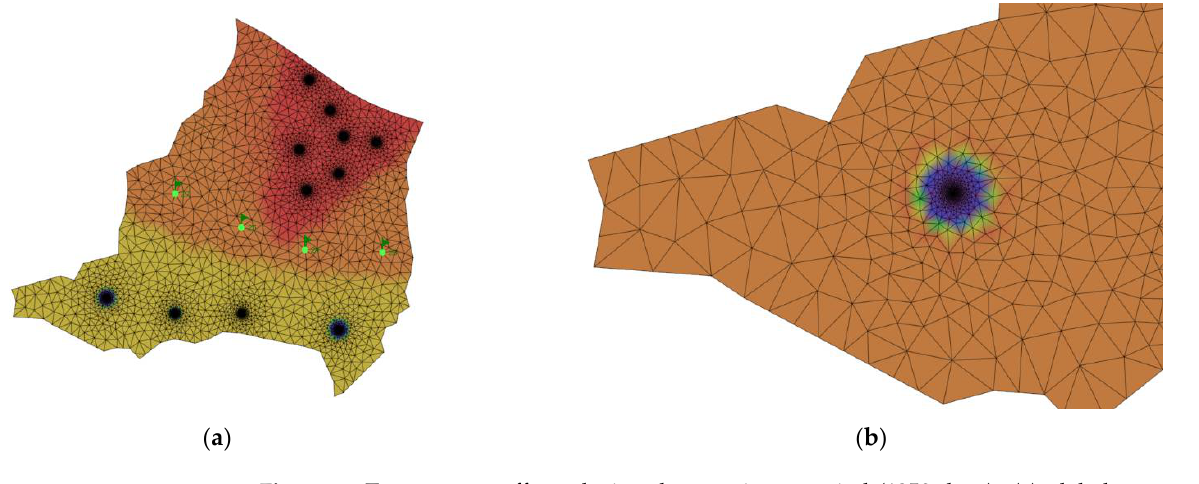
Figure 3. Temperature effects during the transience period (1350 days): ( a ) global temperature dis- tribution; ( b ) local temperature distribution around an injector.